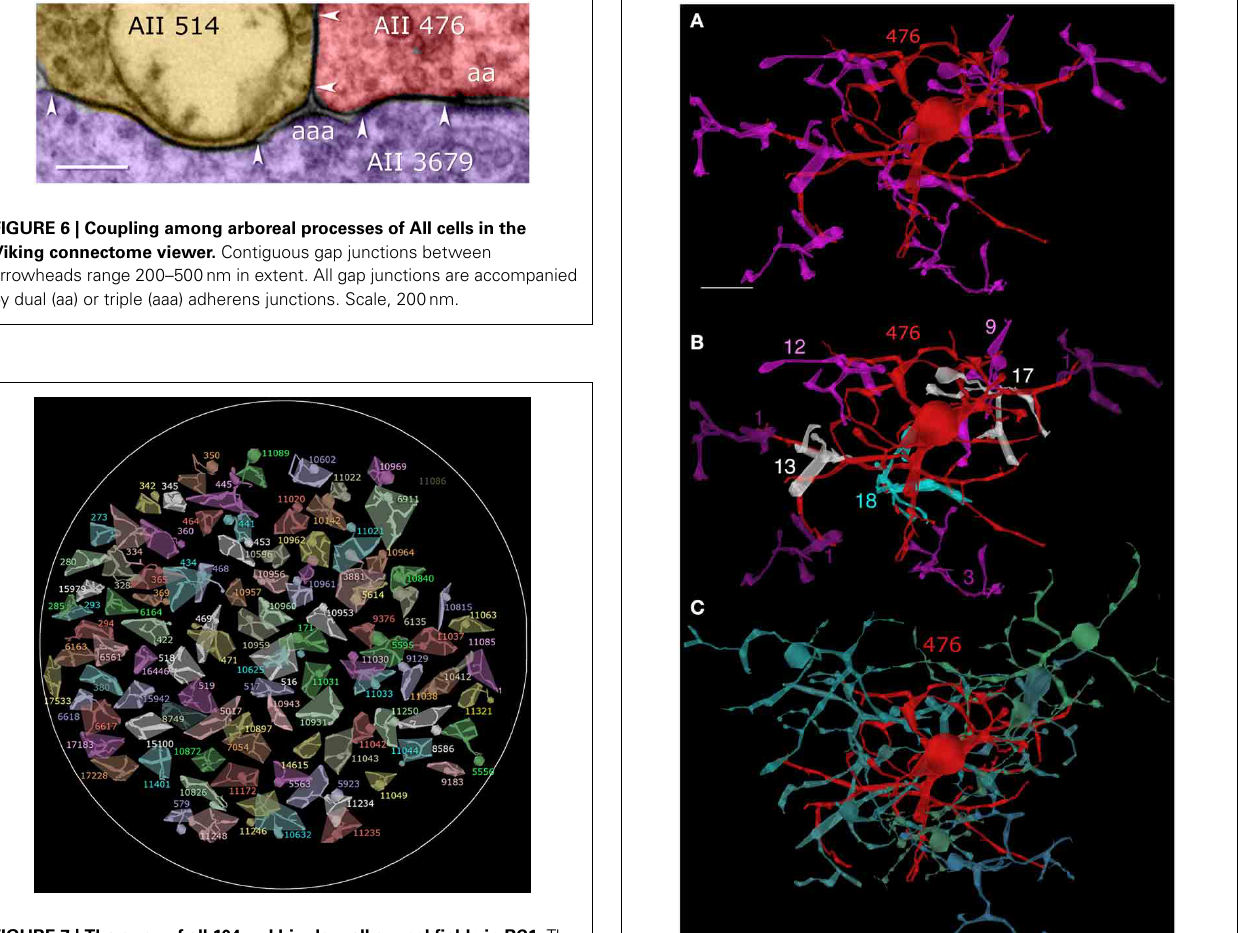
dendrites are always postsynaptic to rod bipolar cells and never presynaptic, in 777 verified encounters from 1246 ribbons.